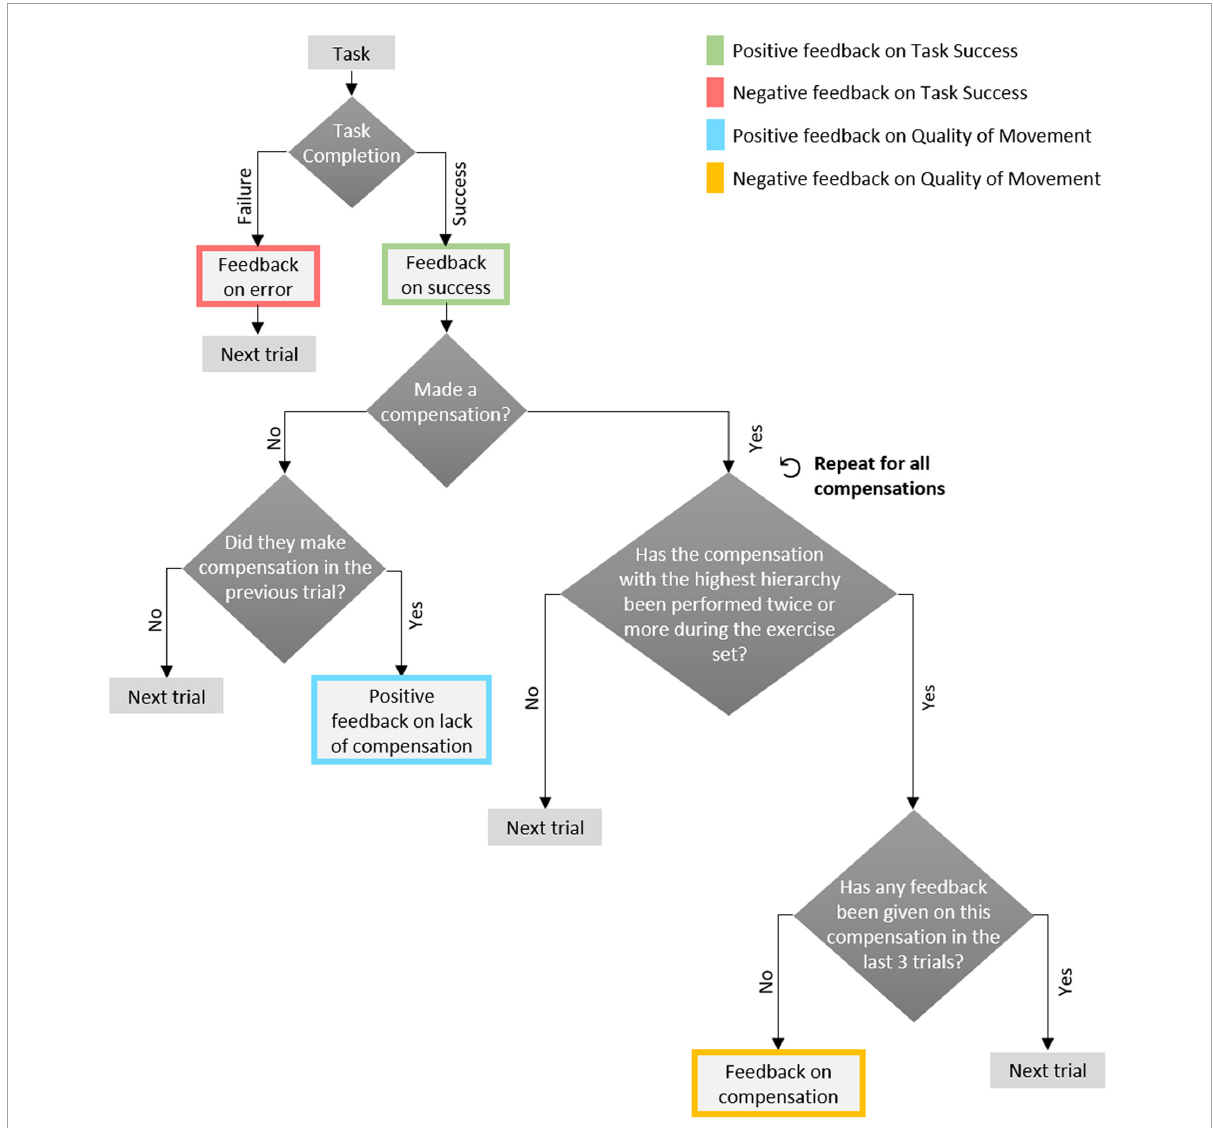
FIGURE2 The decision tree used in the experiment. It is depicted as a flow chart, and is based on the hierarchical structure suggested by clinicians in a previous study (Fruchter et al., 2022): feedback on task success precedes feedback on compensations; within compensations, order is set by the clinician (here, set to a default order: trunk flexion, scapular elevation and elbow flexion).